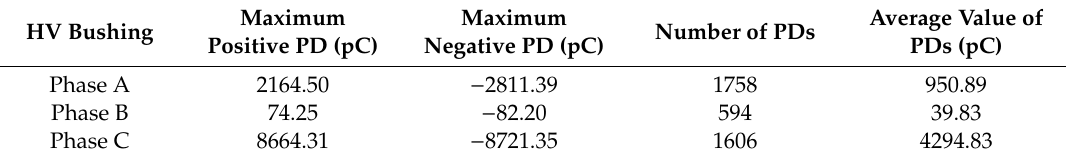
Table 5. PD measurements on day 3.